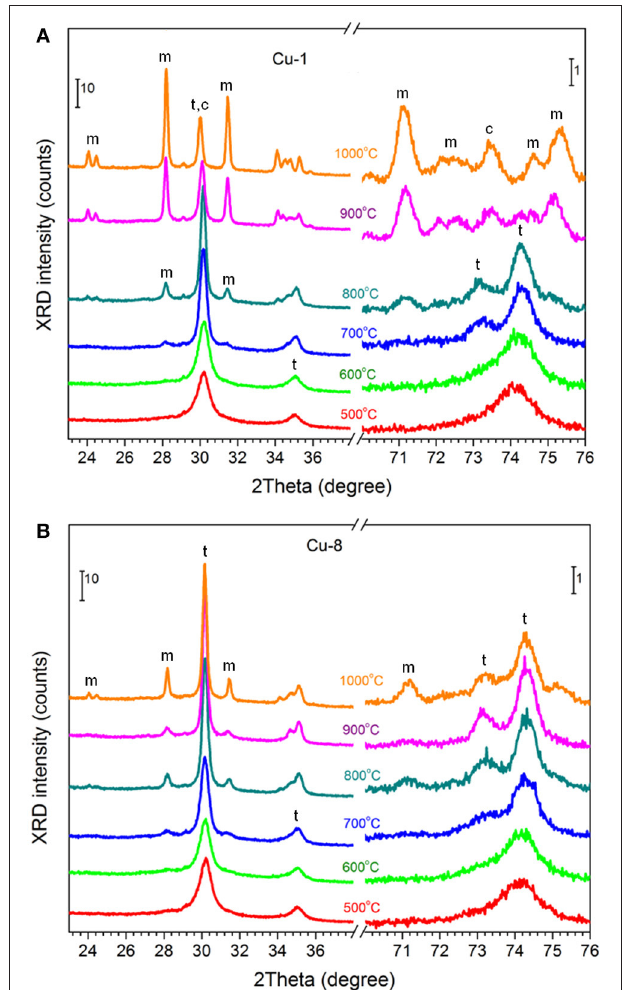
FIGURE 1 | XRD patterns of Cu-1 (A) and Cu-8 (B) powders calcined at different temperatures. XRD peaks of monoclinic, tetragonal and cubic phases are marked with “m”, “t” and “c”. Only peaks that do not overlapped significantly are